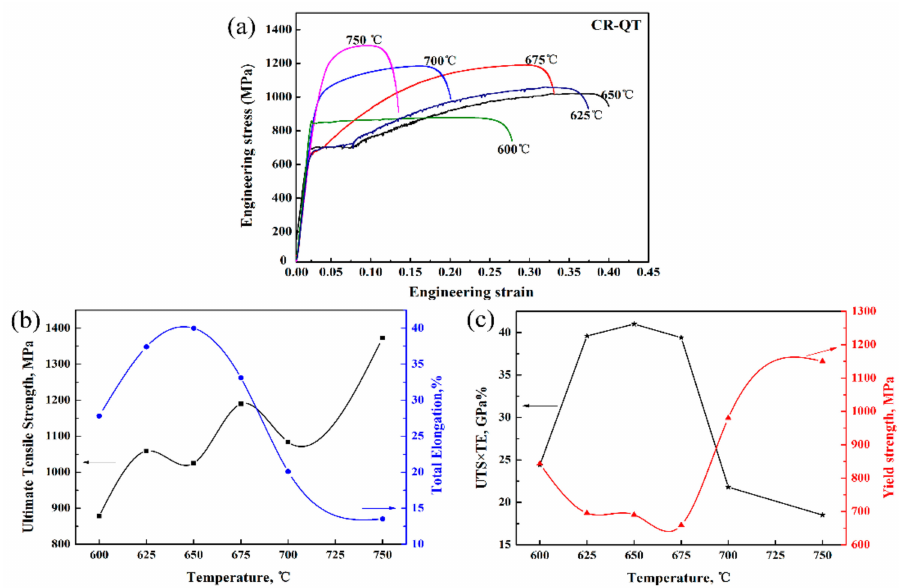
Figure 7. Tensile properties of experimental steels at different annealing temperatures. ( a ) engineering stress–strain curves, ( b ) ultimate tensile strength and total elongation and ( c ) UTS × TE and yield strength. (UTS × TE: product of ultimate tensile strength and total